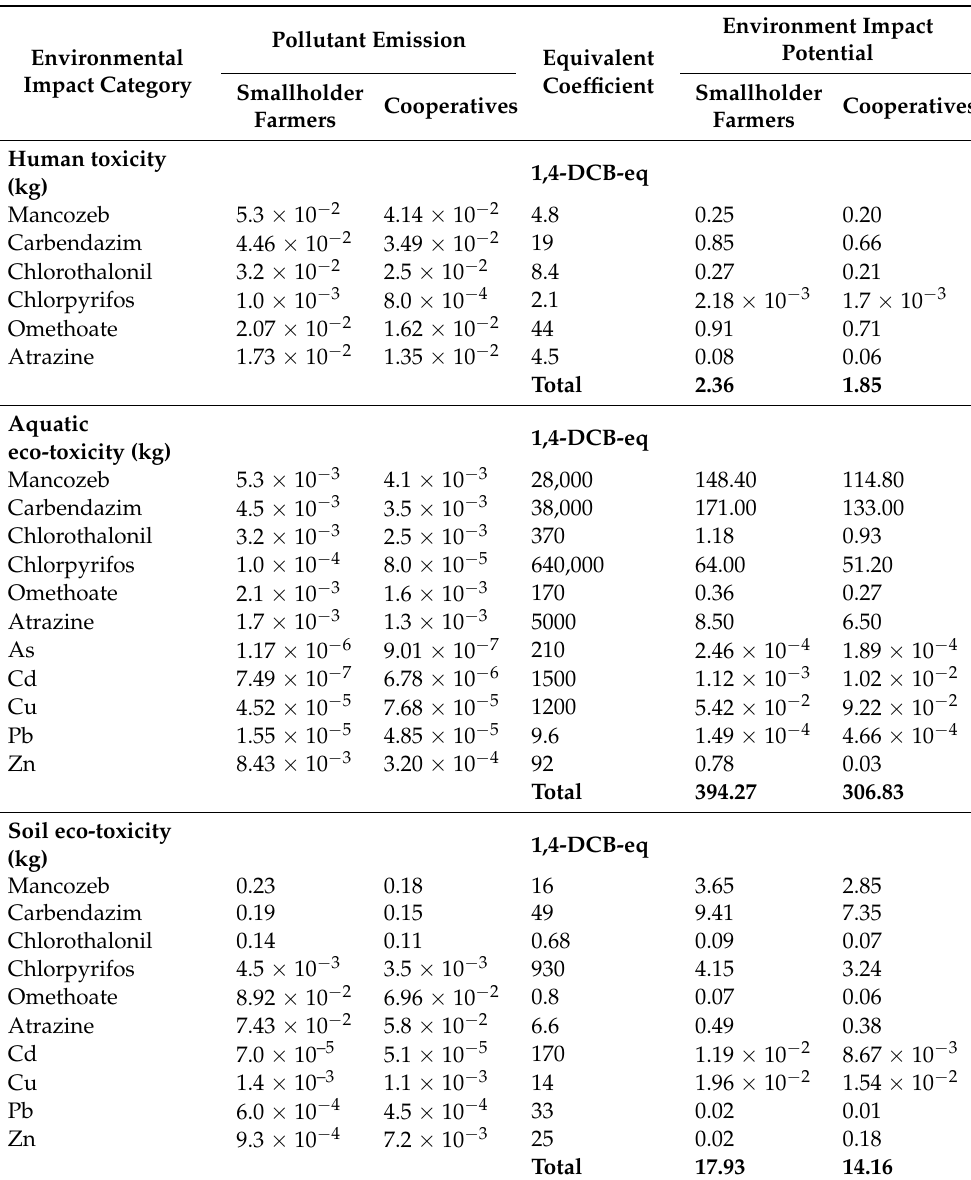
Table 5. Characterization of per ton of apple production in human toxicity, aquatic eco-toxicity, and soil